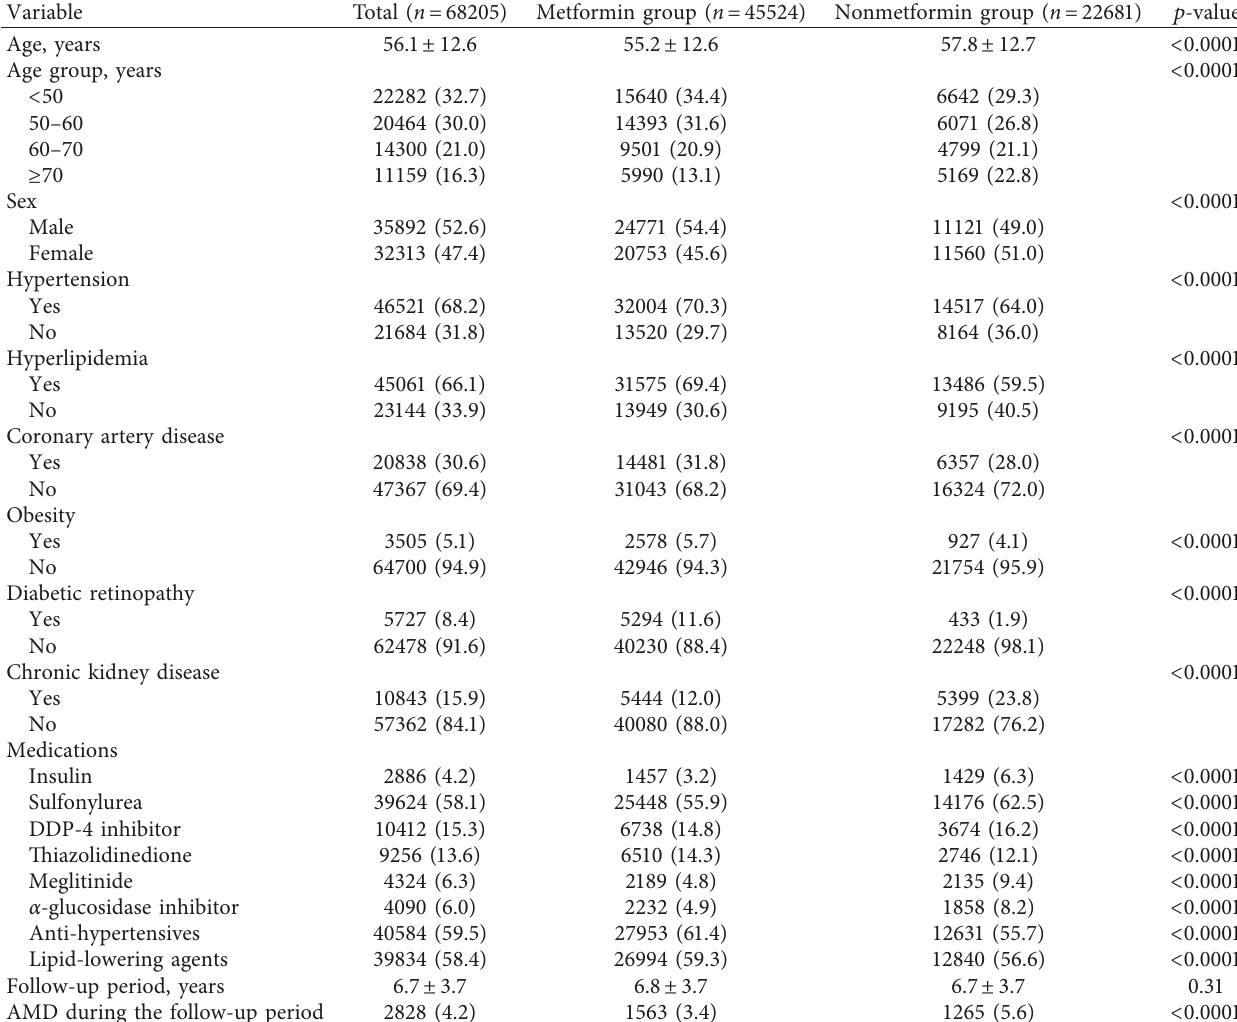
Table 1: Characteristics of the study